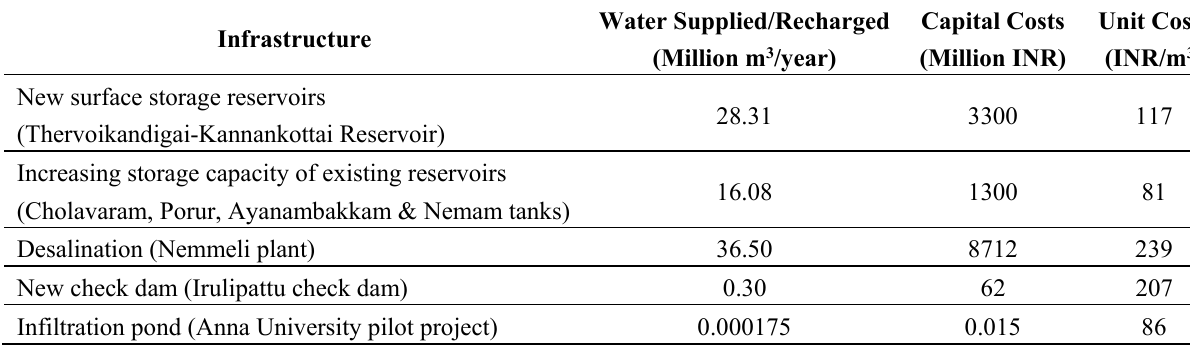
Table 1. Capital costs for water supply